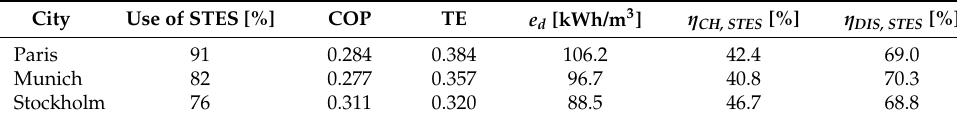
Table 11. KPIs of the sorption storage system.